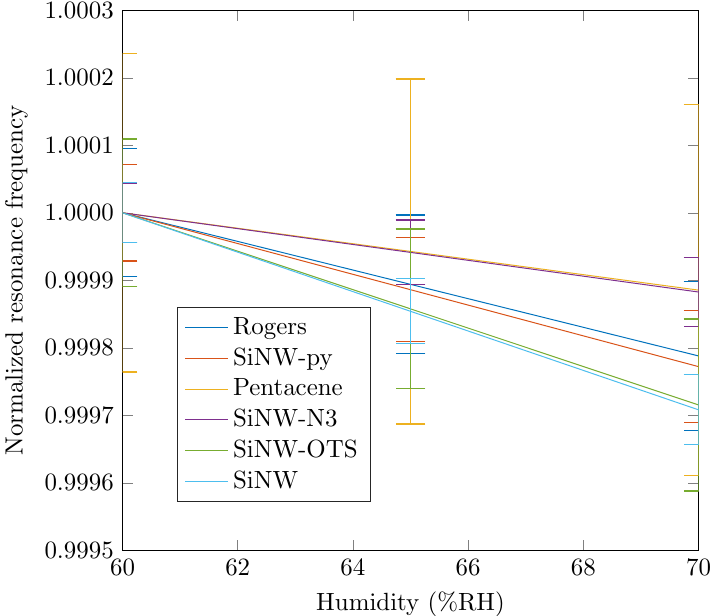
Figure 11. Normalized resonance frequencies for different temperatures at a constant temperature of T = 40 °C (normalized by the initial frequency at